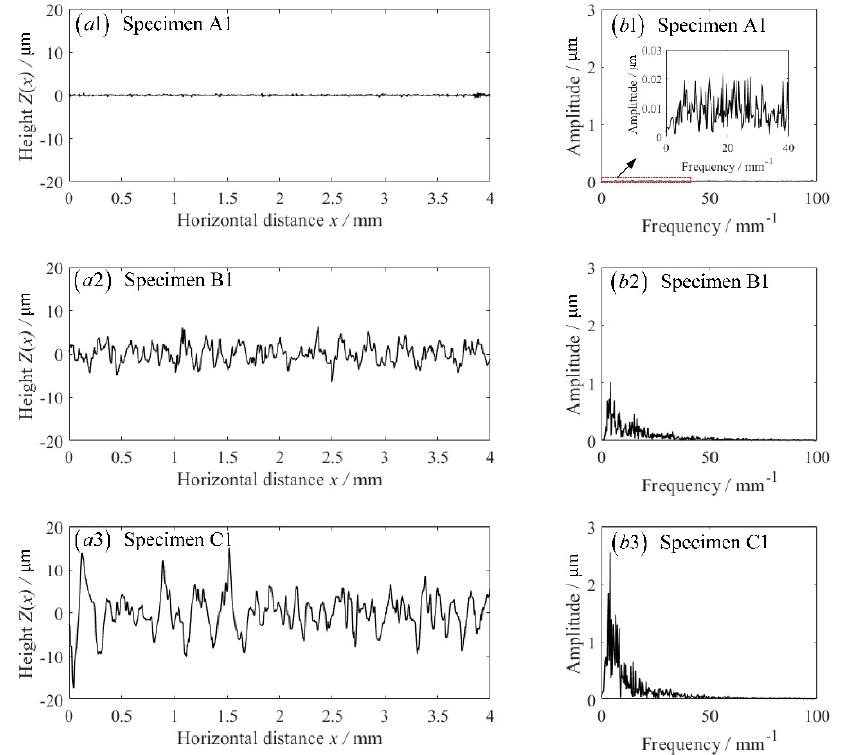
Figure 6. Machined surface topographies and their amplitude-frequency analysis. ( a1 , a2 , a3 ) the machined surface topographies measured from specimens A1, A2 and A3; ( b1 , b2 , b3 ) the amplitude-frequency relationships for the machined surface topographies in ( a1 , a2 , a3 ).